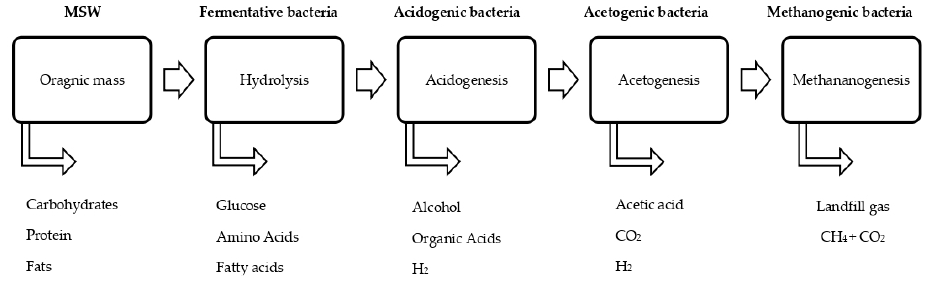
Figure 2. Scheme of biochemical reactions during anaerobic digestion in landfill [4].